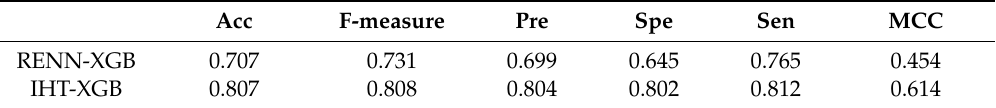
Table 2. The prediction performance of two re-balance